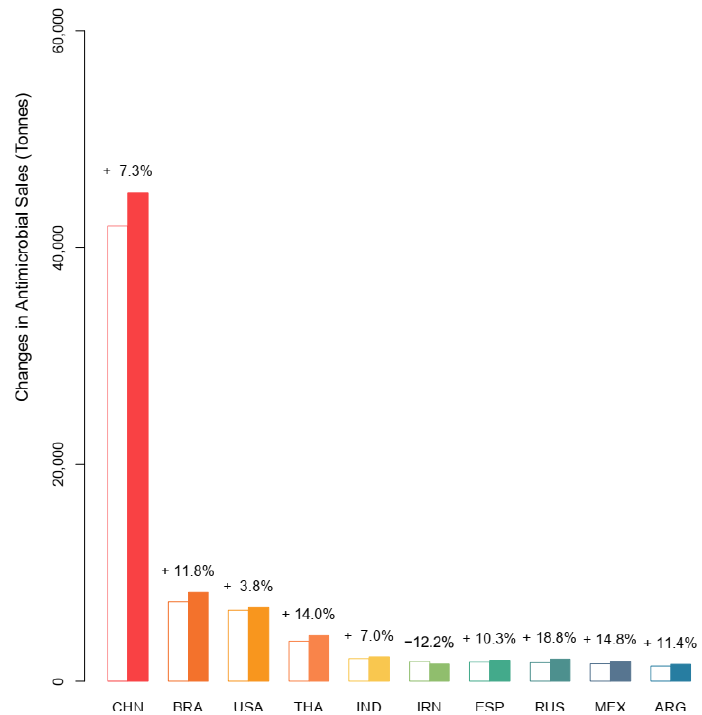
Figure 2. The top 10 consumers of veterinary antimicrobials by country in 2017 (open bars) and their projected consumption for 2030 (closed bars). CHN, China; BR, Brazil; USA, United States; THA, Thailand; IND, India; IRN, Iran; ESP, Spain; RUS, Russia; MEX, Mexico; ARG,